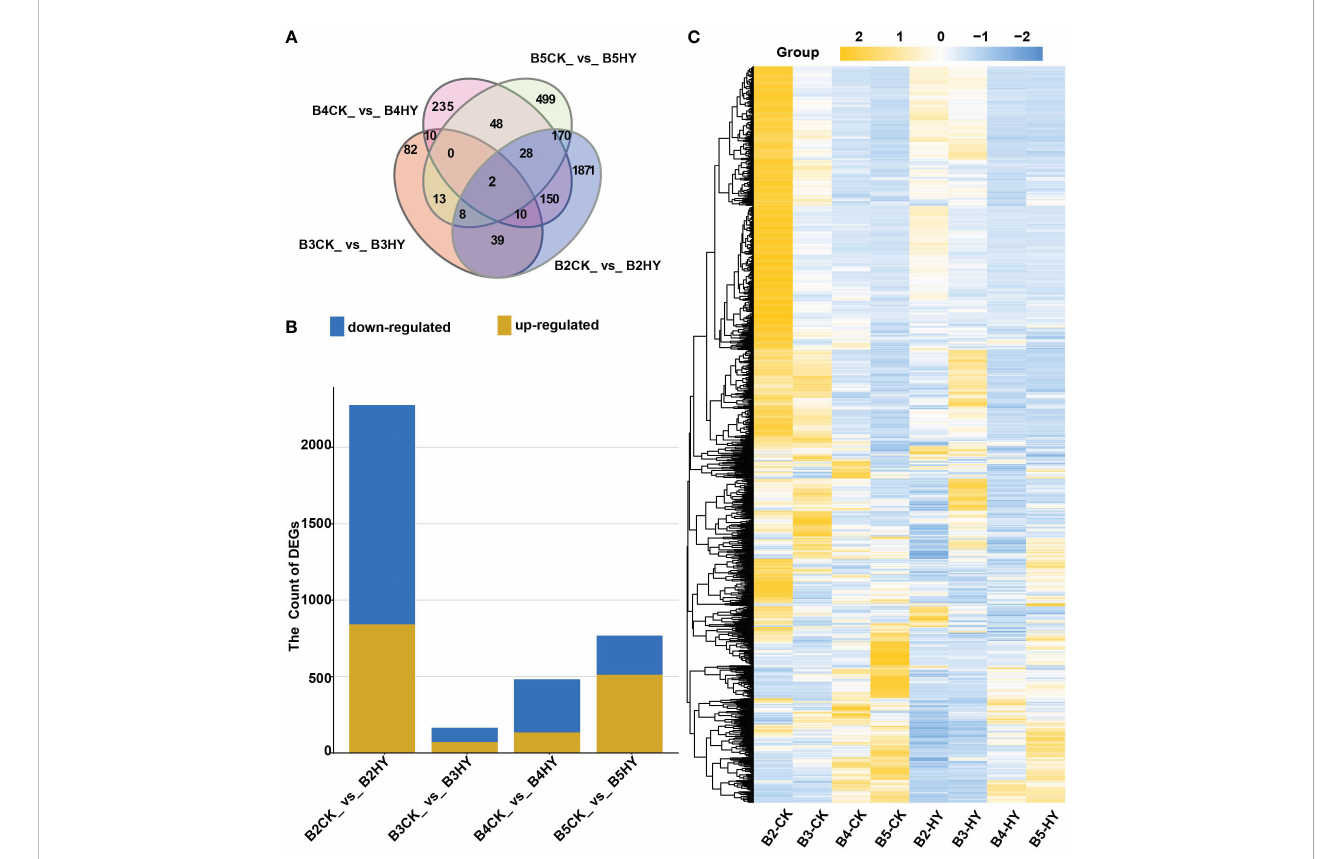
FIGURE 2 RNA sequence analysis was used to identify the number of differentially expressed genes (DEGs) in different treatment periods of Gemstone seedless grape. (A) Venn diagram representing the number of DEGs. (B) The overall total of DEGs used for each comparison. Yellow represents up-regulated and blue represents down-regulated. (C) The heat map analysis of